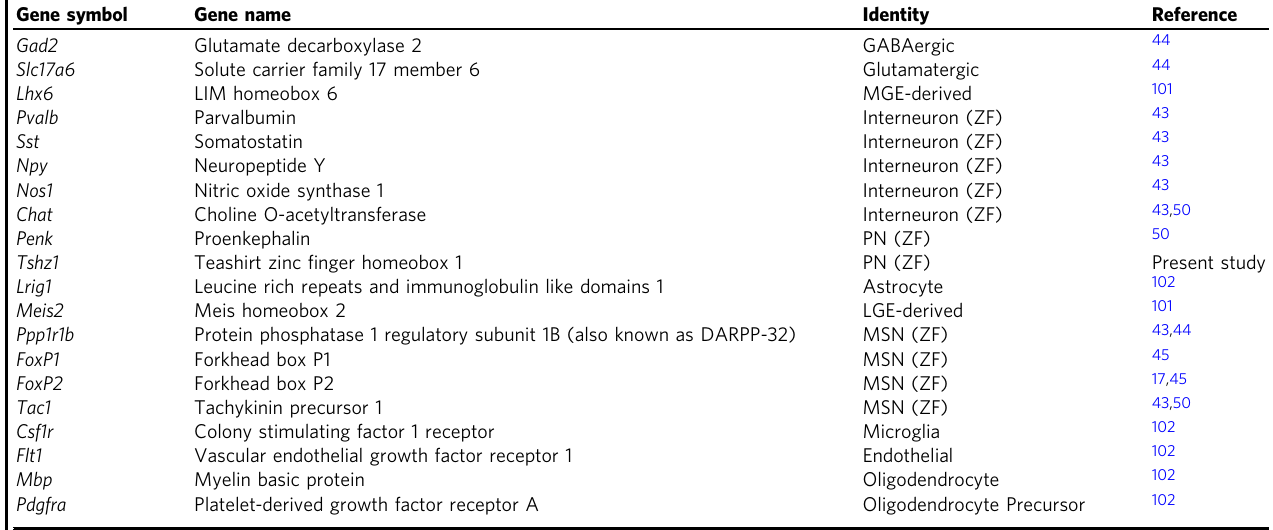
Table 1 Gene markers for cluster